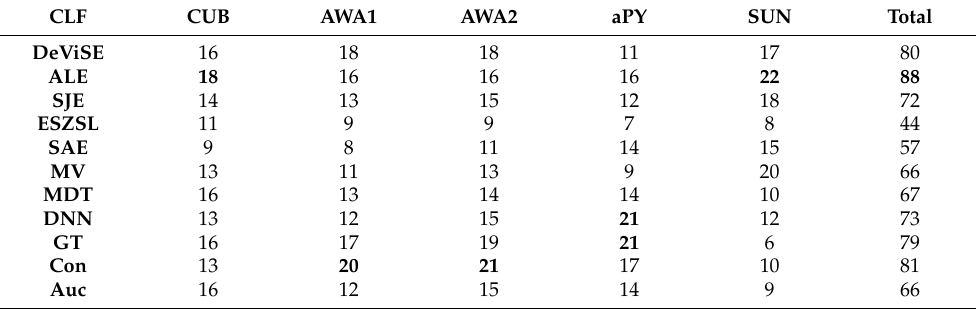
Table 12. Individual Classifier and Meta-Classifier Combined